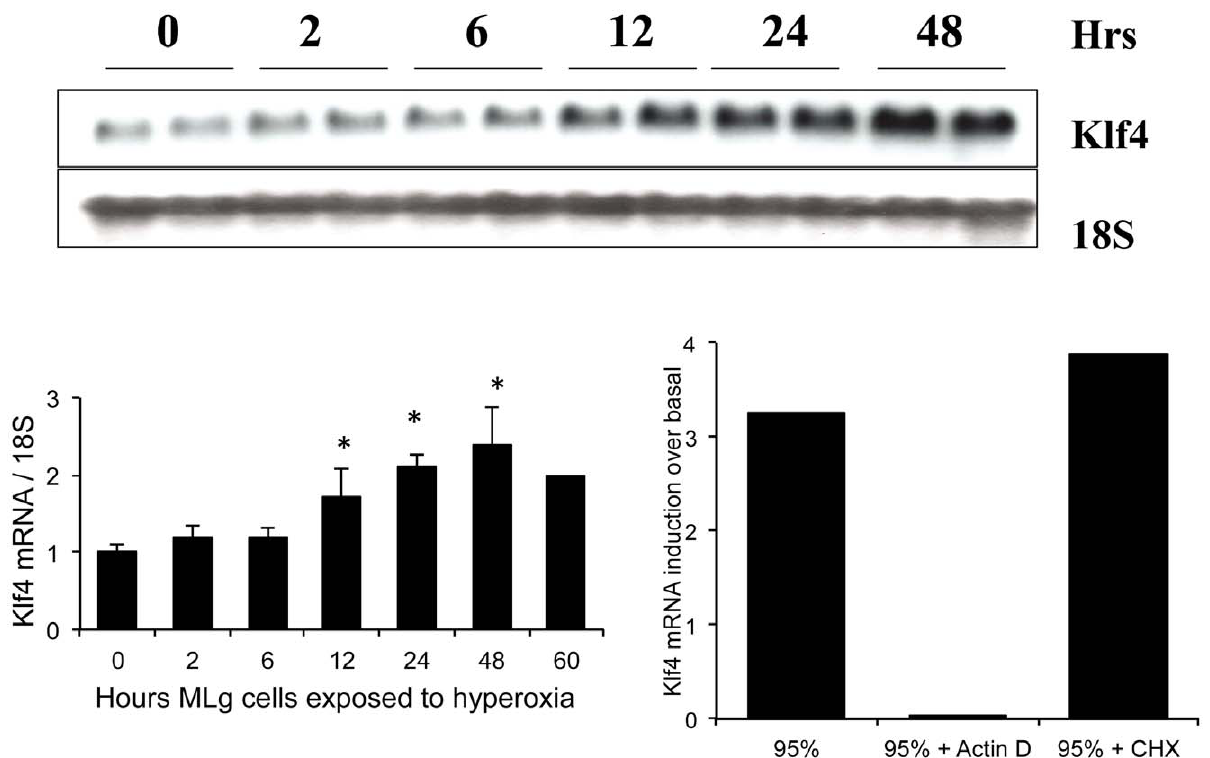
Figure 5. Regulation of fibroblast Klf4 messenger RNA expression by oxygen. Exposure of mouse lung fibroblasts (MLg cells) to 95% oxygen induces Klf4 mRNA by 2.1 fold after 12 h (n=4, p , 0.05) and 2.8-fold by 48 h (n=4, p , 0.05). Klf4 mRNA induction in MLg cells exposed to